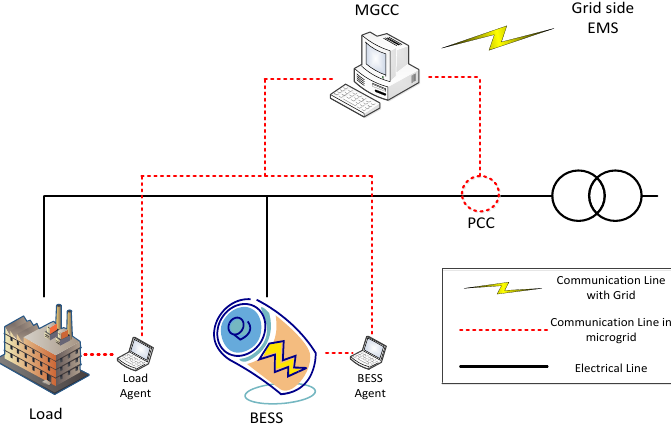
Figure 1. Configuration of microgrid in this paper.